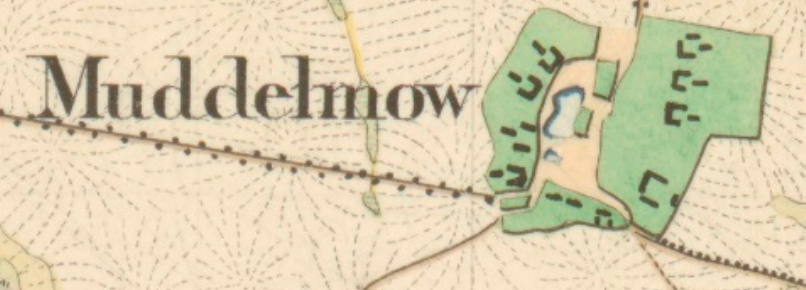
Figure 2. The oldest preserved map of the village of Modlimowo from 1834. It shows the outline of the earlier layout of the circular village. A fragment of a circular village visible on the plan on the left. Created by author.